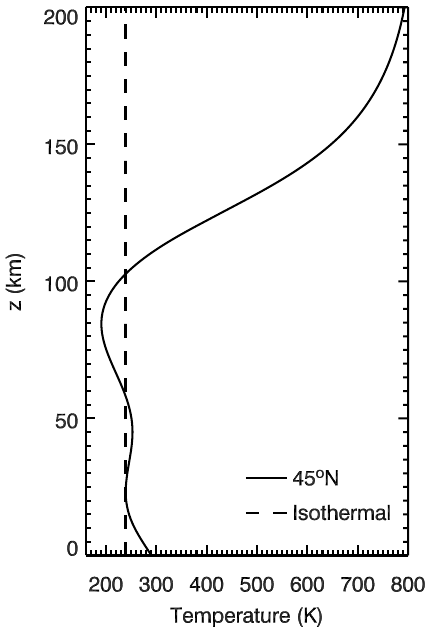
Fig. 2. Profiles of the isothermal (dash) and the non-isothermal (solid) backgrounds used in this paper.